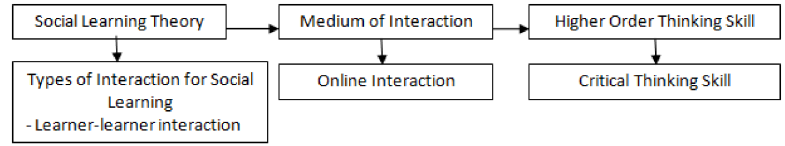
Figure 2. The revised of the figure from Figure